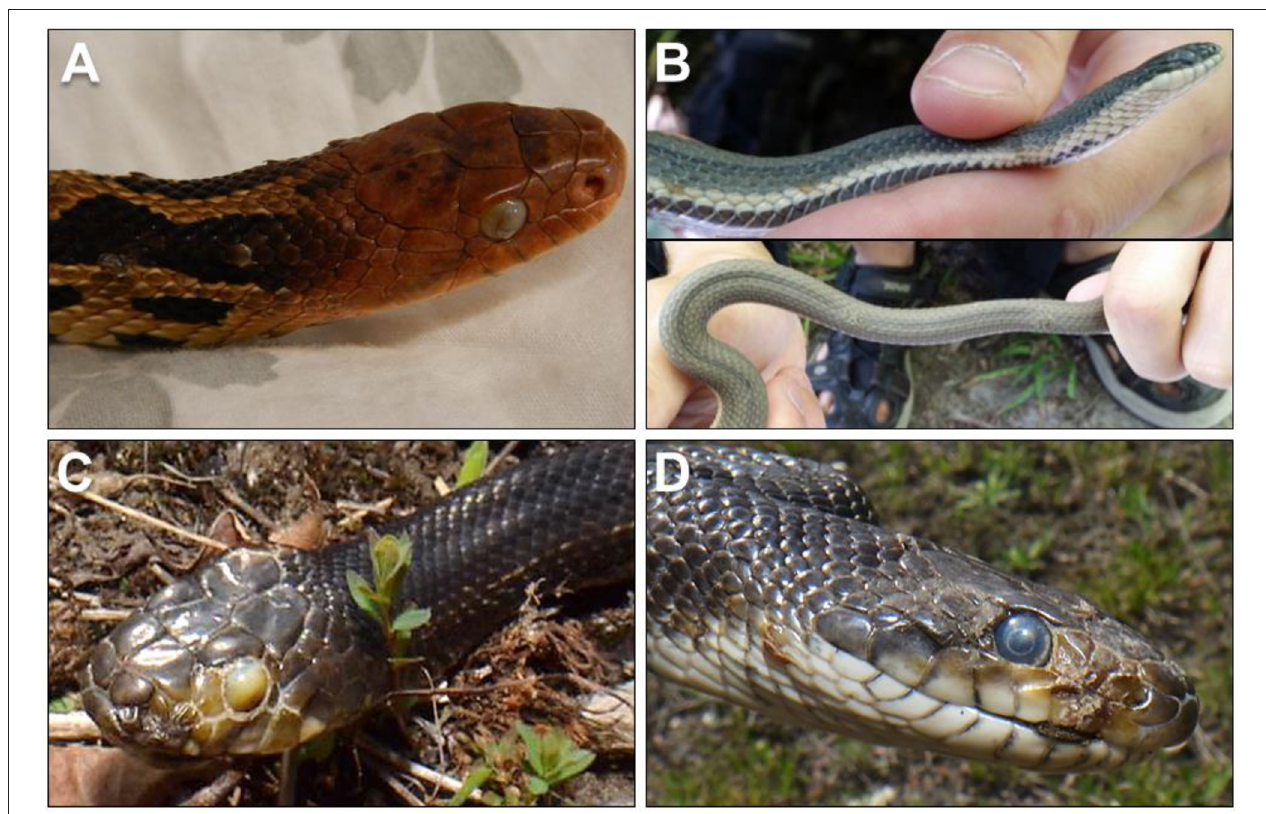
FIGURE 1 | (A) Ophidiomycosis manifesting in gross lesions on the skin and eye of an eastern foxsnake ( Pantherophis vulpinus ) with a plaque of fungal hyphae growing over the eye (photo: Sheeva Nakhaie). (B) Ophidiomycosis on a queensnake ( Regina septemvittata; photos: Heather Fotherby); (C,D) Gray ratsnake ( Pantherophis spiloides; photos: Kenny Ruelland) from southeastern Ontario, Canada with suspect